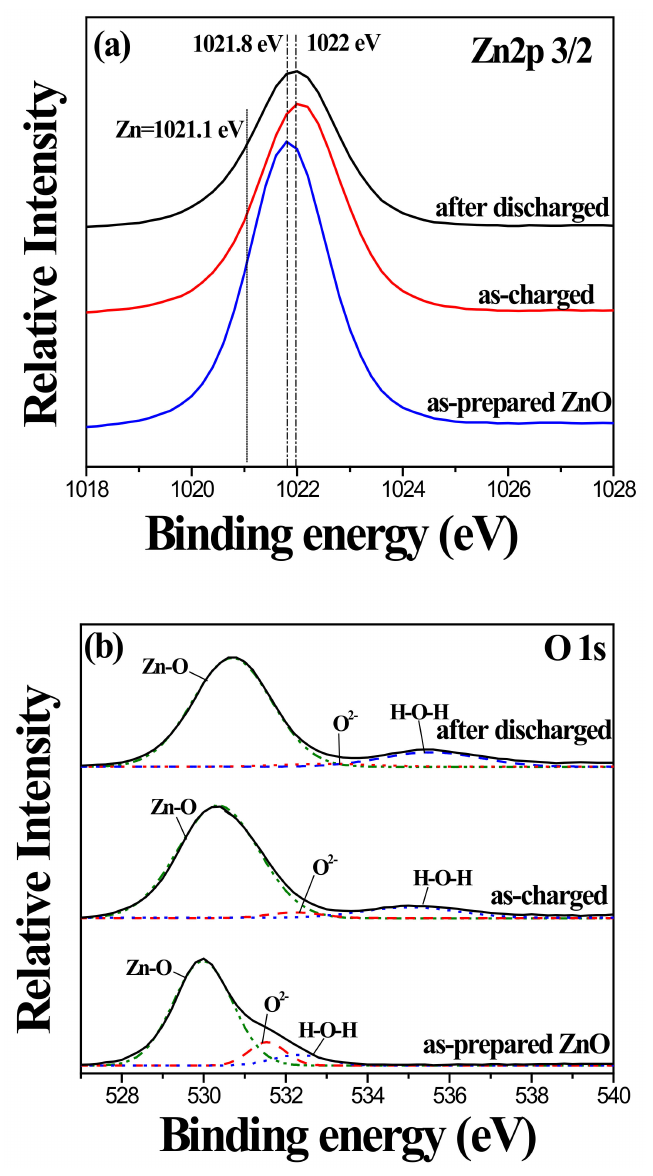
Figure 10. ( a ) Zn 2p 3 / 2 and ( b ) O 1s XPS spectra of uncoated ZnO nanorod before and after CV